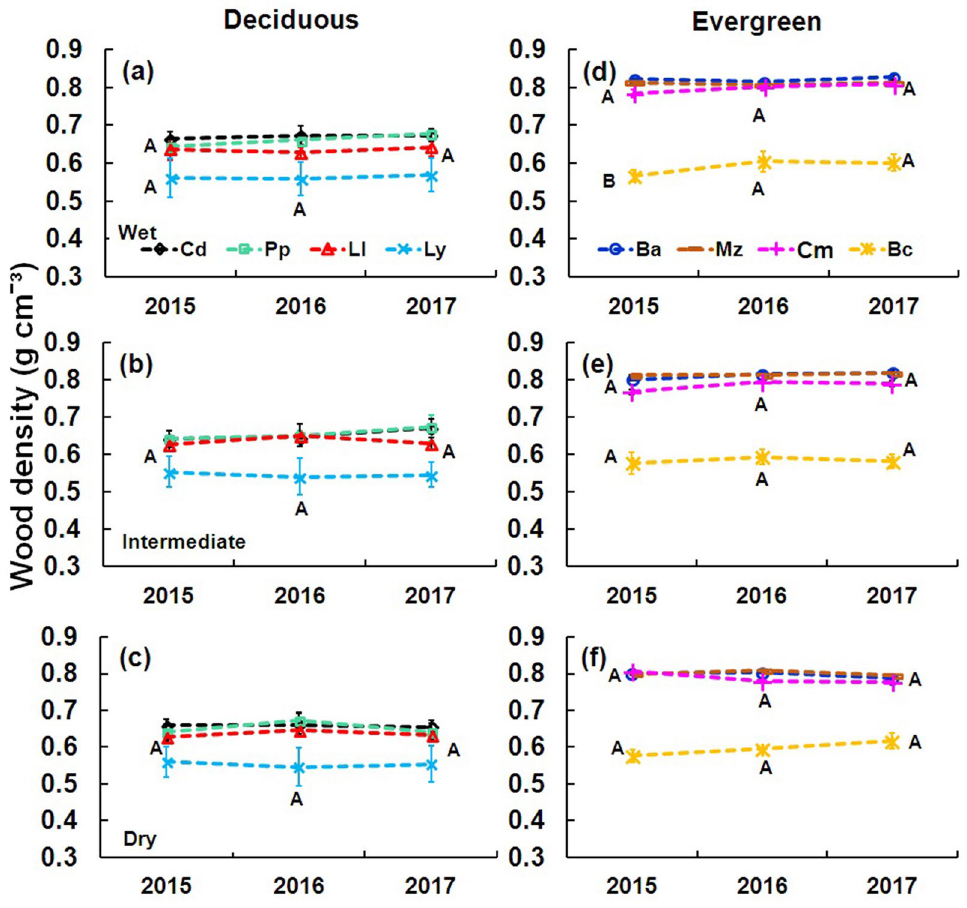
Figure 2. Wood density of deciduous and evergreen species from 2015 to 2017 considering young and mature diameter categories. Deciduous species ( a – c ): Cordia dodecandra (Cd), Piscidia piscipula (Pp), Leucaena leucocephala (Ll), Lysiloma latisiliquum (Ly). Evergreen species ( d , e ): Brosimum alicastrum (Ba), Manilkara zapota (Mz), Chrysophyllum mexicanum (Cm), Byrsonima crassifolia (Bc). Data are means ± SE. Capital letters next to the species indicate significant differences among